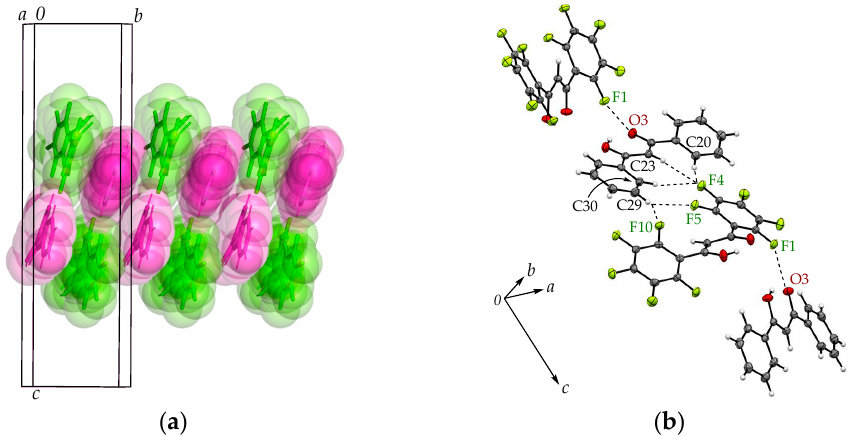
Figure 4. Packing structures of H 1 •H 3 : ( a ) the comprehensive view of the stacking structure and ( b ) major intermolecular interactions.